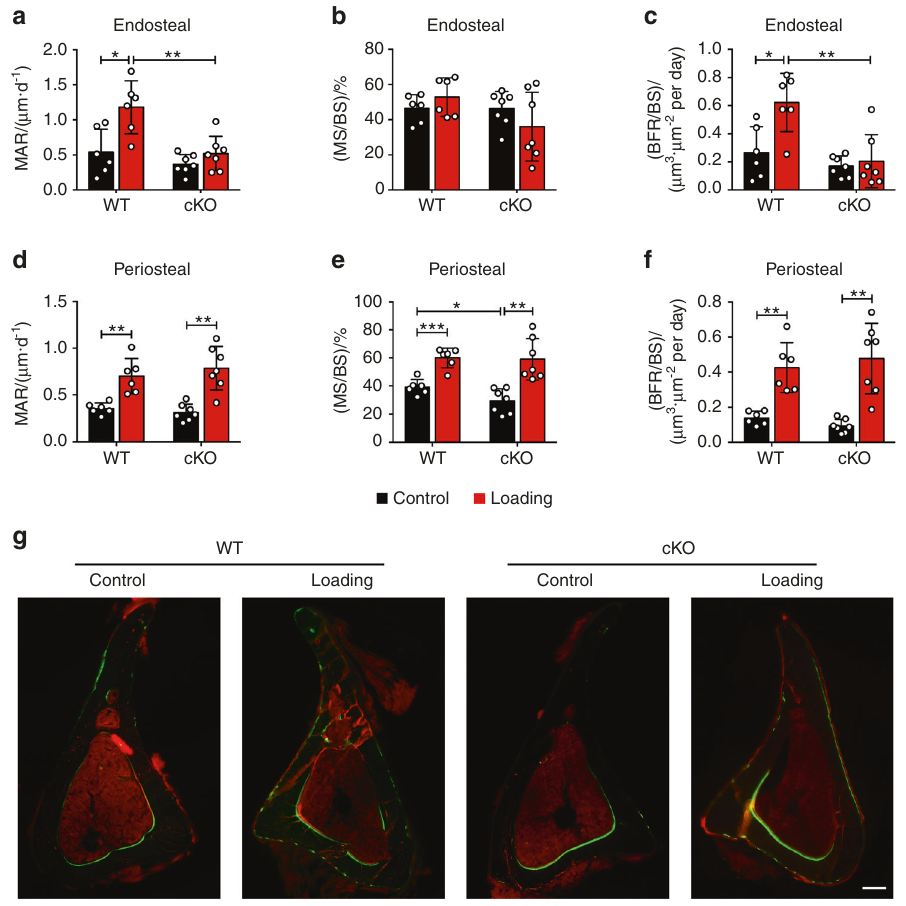
Fig. 4 Integrin α 5 deletion in osteocytes inhibited increased midshaft endosteal osteogenesis by mechanical load. Bone dynamic histomorphometry was conducted on the tibias within diaphyseal 37% cortical VOI, for both loaded and contralateral, unloaded tibias of WT and cKO mice. Mineral apposition rate (MAR) ( a , d ), mineralizing surface/bone surface (MS/BS) ( b , e ), and bone formation rate/bone surface (BFR/BS) ( c , f ) were assessed along endosteal ( a – c ) and periosteal ( d – f ) surfaces of all tibias. n = 6 per group. G Representative images of calcein (green) and alizarin (red) double labeling at the 37% VOI for all groups. Scale bar: 200 μ m. n = 6 per group. Mean ± SD. * P < 0.05; ** P < 0.01; *** P < 0.001. Paired t test was performed for loaded and contralateral tibias and unpaired t test was performed for loaded or control tibias between WT and cKO con fi rmed that the decreased Sost and increased COX-2 and β -catenin gene expression observed was impeded in cKO mice (Fig. 7l – n). The results indicate that during mechanical loading, deletion of integrin α 5 from osteocytes impedes the release of PGE2 and then decreases SOST in osteocytes, which is correlated with impeded β -catenin expression and osteoblast activity on the endosteal surface.